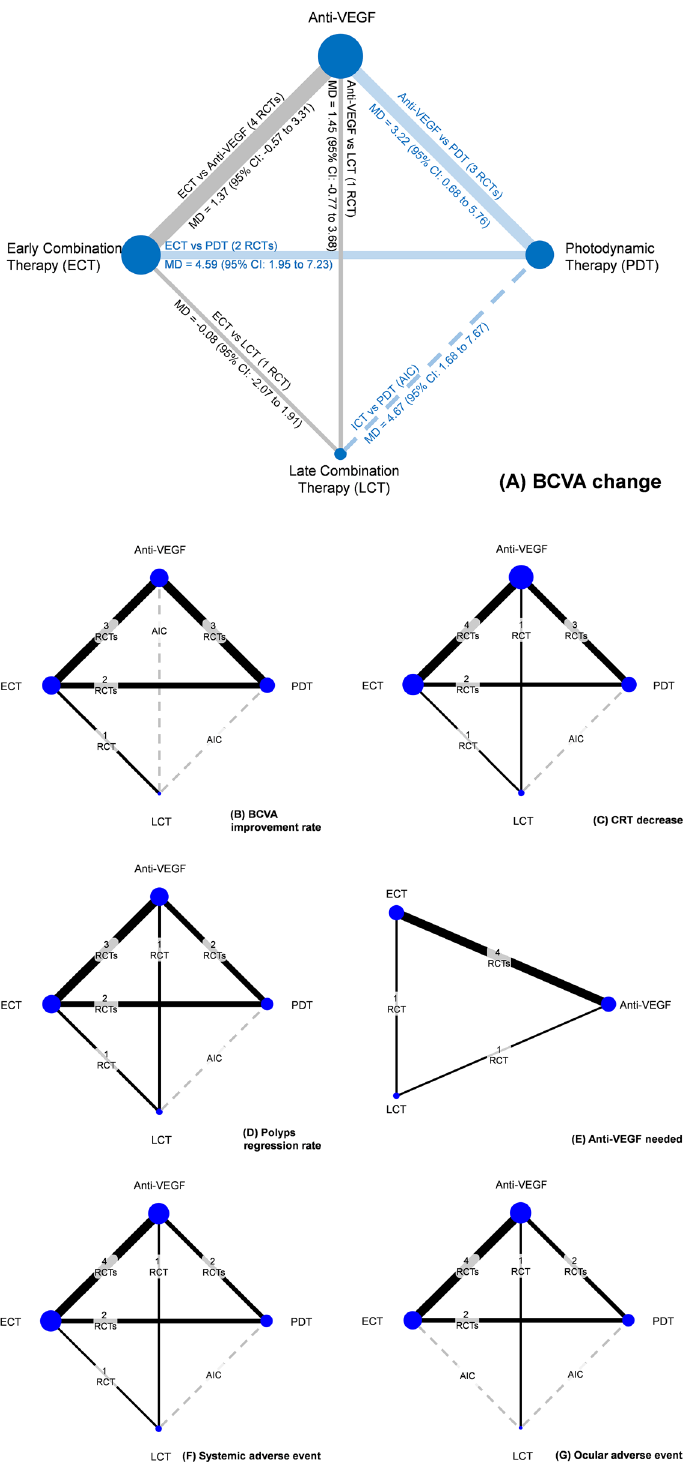
Figure 1. Network